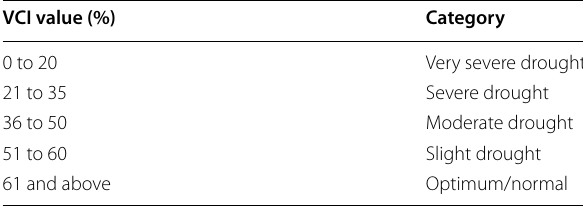
Table 3 Metrological drought risks classification using SPI value (McKee et al.